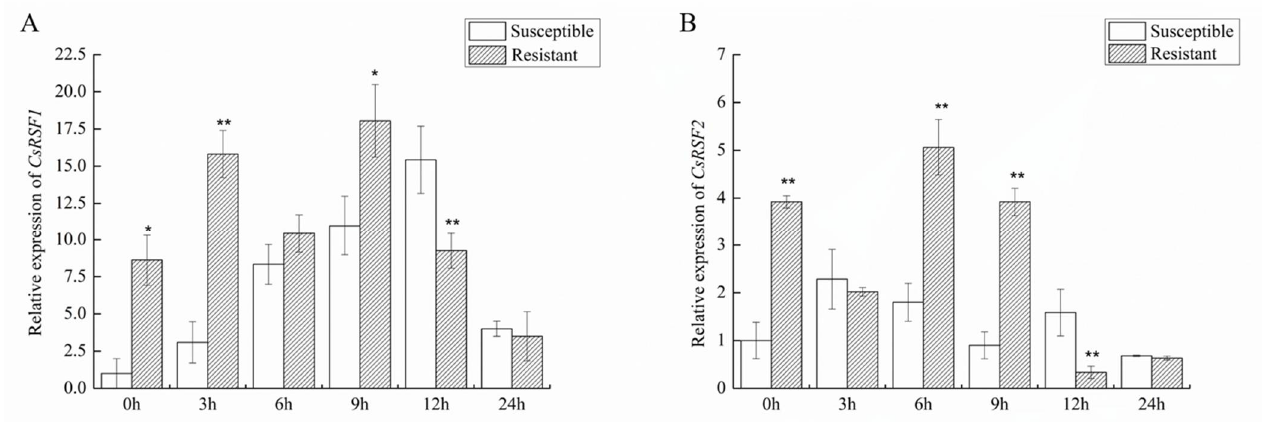
Figure 4. Expression patterns of CsRSF1 and CsRSF2 in resistant (B21-a-2-1-2) and susceptible (B21-a-2-2-2) varieties were inoculated with S. fuliginea . ( A ) The expression of CsRSF1 in resistant and susceptible varieties were inoculated with S. fuliginea . ( B ) The expression of CsRSF2 in resistant and susceptible varieties were inoculated with S. fuliginea . Expression analysis of candidate genes at 0, 3, 6, 9, 12 and 24 hpi (hours post-inoculation) using the 2 − ∆∆ C t method. The expression level in B21-a-2-2-2 was the mock control as 1. Data are means ± standard deviations (SD) from three biological replicates per cultivar. The asterisks indicated a significant difference (Student’s t -test, * p < 0.05 or ** p < 0.01).